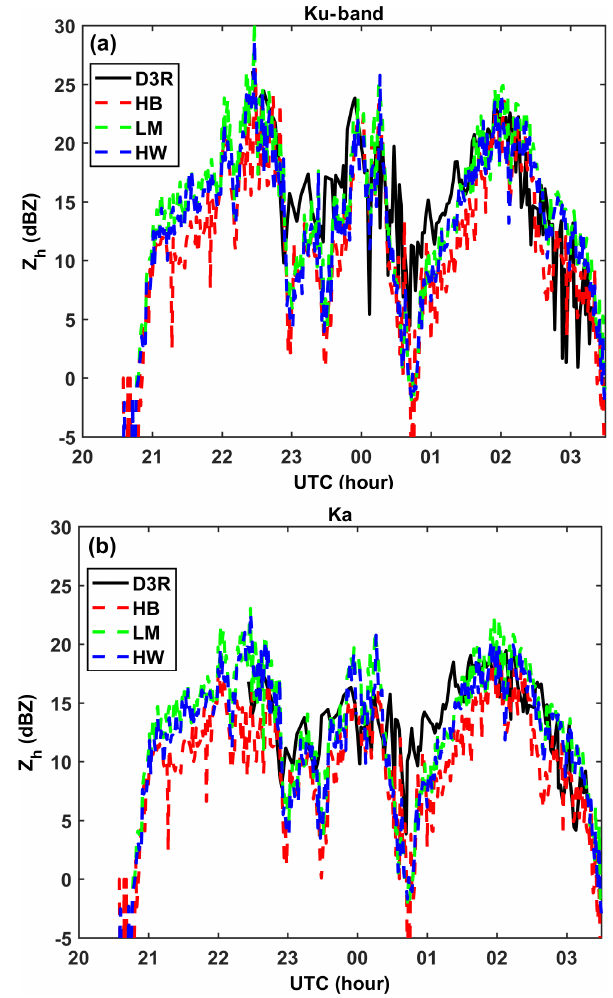
Figure 11. Comparison of the 2DVD-derived Z h with D3R mea- surements for the entire event, Ku-band (a) , and Ka-band (b) . This synoptic system started at around 21:00Z on 30 January and ended at around 03:30Z on 31 January 2012. Z e by LM is close to HW and slightly higher, whereas the HB method gives the lowest Z e . Z e results computed by all methods generally agree with D3R mea- sured Z h